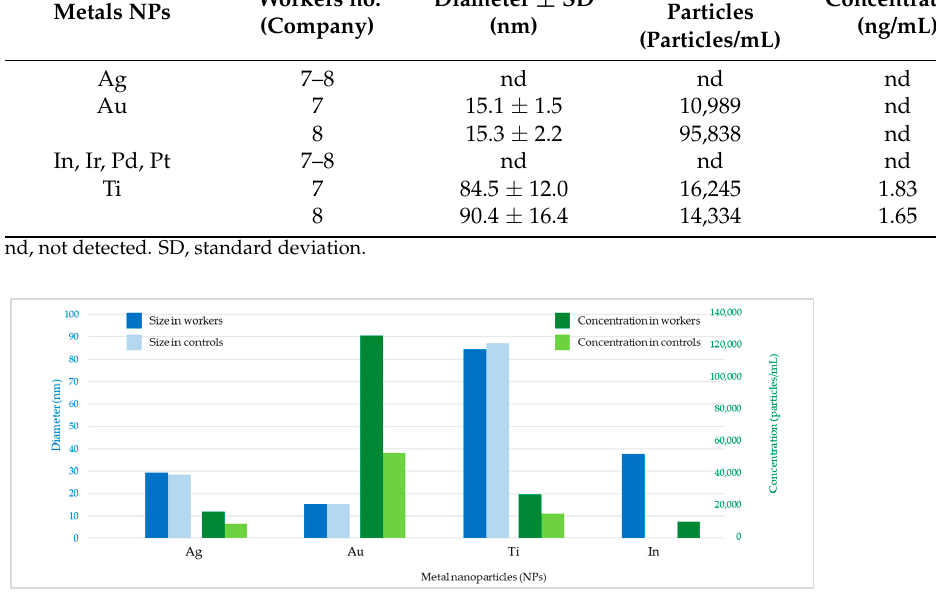
Figure 5. Mean diameter (nm) and number concentration (particles/mL) of metal nanoparticles (NPs) for workers and controls of the two companies.